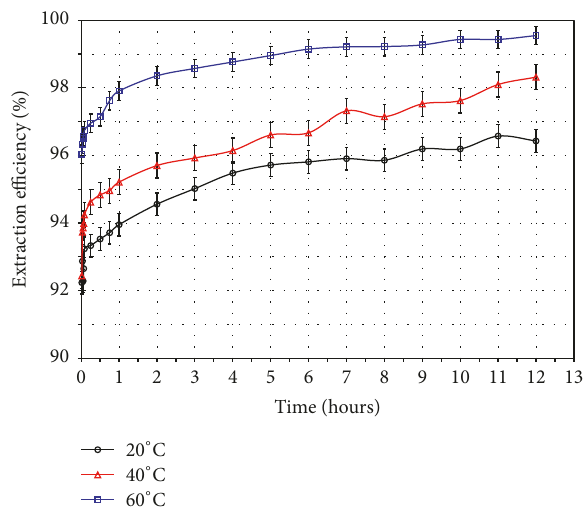
Figure 3: Extraction kinetics of the raw oil according to the temperature and extraction